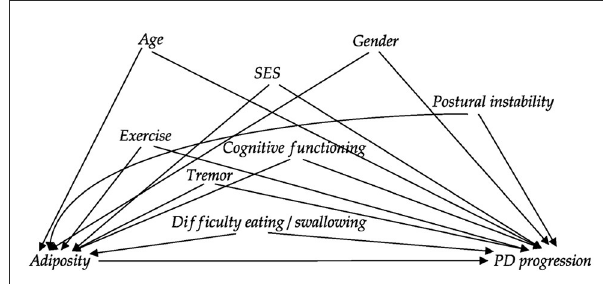
FIGURE1 Directed acyclic graph (DAG) reflecting the assumed relationships between variables for the analysis of the effect of adiposity on PD progression. Relationships between confounders are not shown to avoid clutter (and because these did not alter the required adjustment set). The DAGs were constructed together with multiple clinical PD experts. DAGs for the other exposures are displayed in the supplement. SES: socioeconomic status.